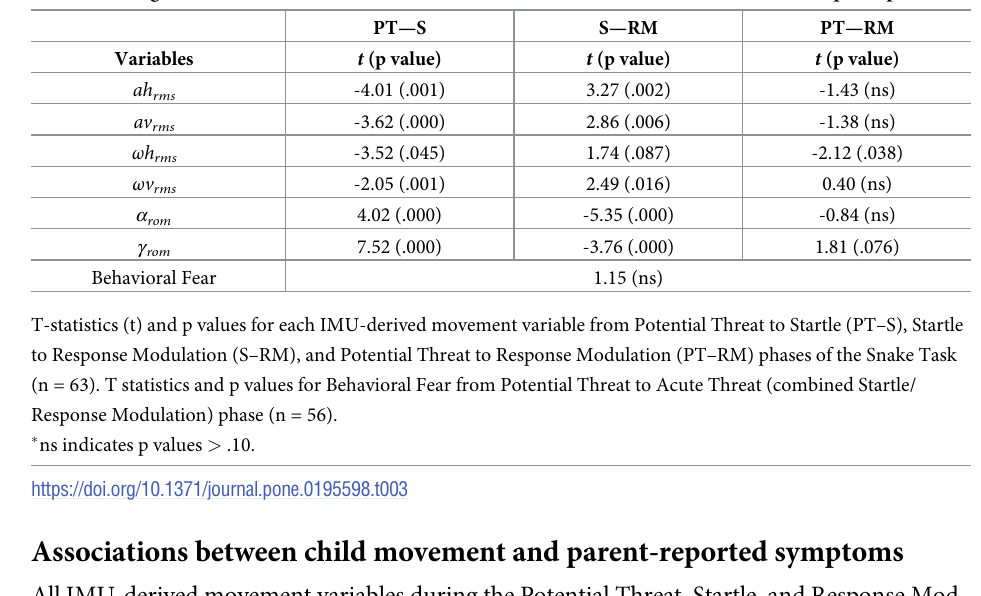
Table 3. Changes in IMU-derived movement variables and behavioral fear codes across threat response